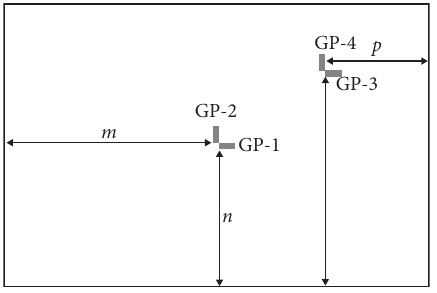
Figure 7: Arrangement of strain gauge.